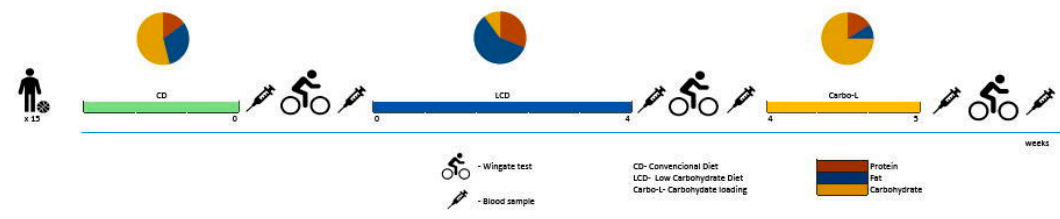
Figure 1. Scheme of the experimental protocol.